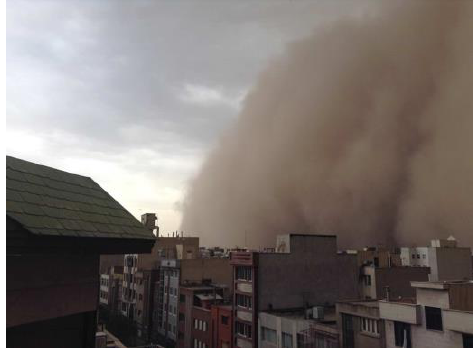
Figure 1. Tehran storm on second of July 2014 (Wall of dust )